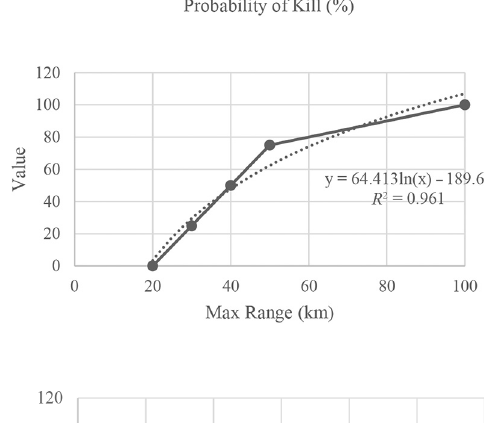
Figure 4. Probability of kill